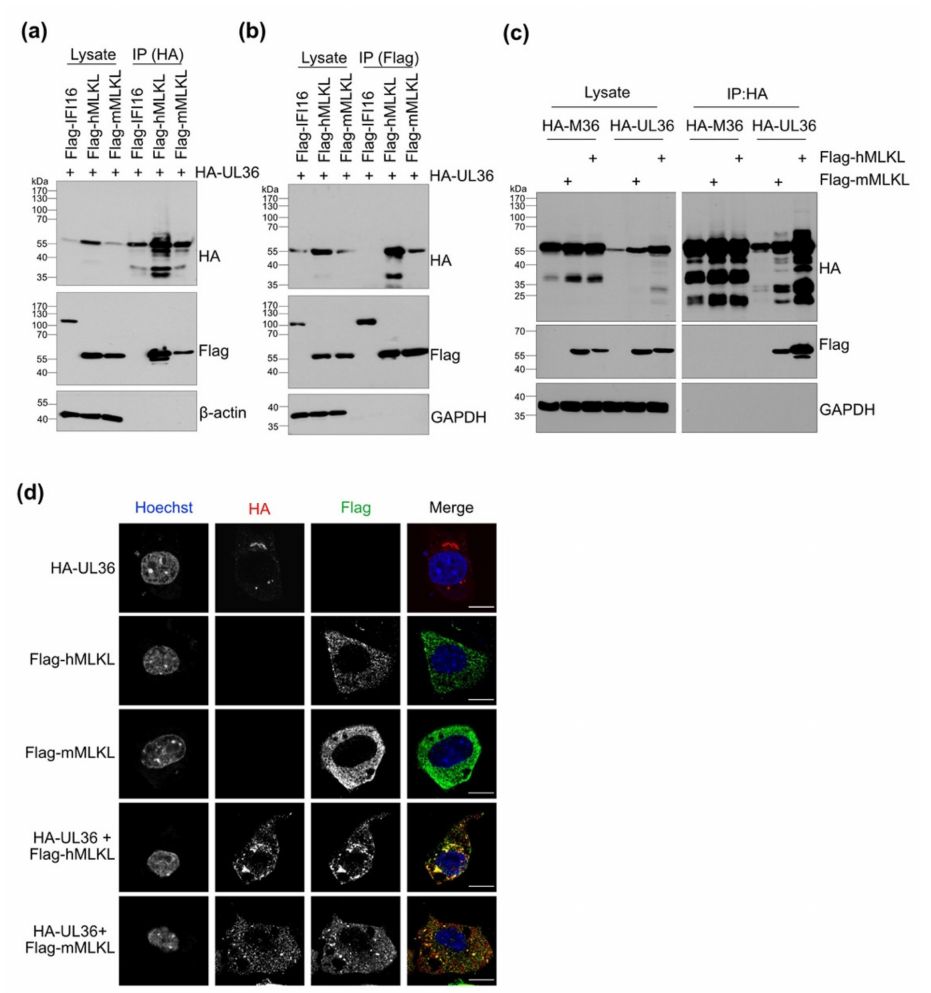
Figure 2. HCMV UL36 co-precipitates and co-localizes with human and murine MLKL. ( a ) HEK-293A cells were co- transfected with plasmids expressing HA-tagged UL36 and either Flag-tagged mMLKL or Flag-tagged hMLKL. HA-UL36 was immunoprecipitated, and co-precipitating Flag-tagged MLKLs were detected by Western blot. Flag-tagged IFI16 was used as a negative control. ( b ) HEK-293A cells were transfected with plasmids as described above. Flag-tagged proteins were immunoprecipitated, and co-precipitating HA-UL36 was detected by Western blot. ( c ) HEK-293A cells were co-transfected with plasmids expressing HA-tagged M36 or UL36 and Flag-tagged mMLKL or hMLKL. HA-tagged proteins were immunoprecipitated, and co-precipitating Flag-tagged MLKLs were detected by Western blot. ( d ) NIH-3T3 cells were transfected with plasmids encoding HA-UL36 (Red), and Flag-tagged hMLKL or mMLKL (Green). At 24 h post-transfection, the proteins were detected by immunofluorescence using tag-specific antibodies. Nuclei were stained with Hoechst 33342 (Blue). Scale bar, 10 µ